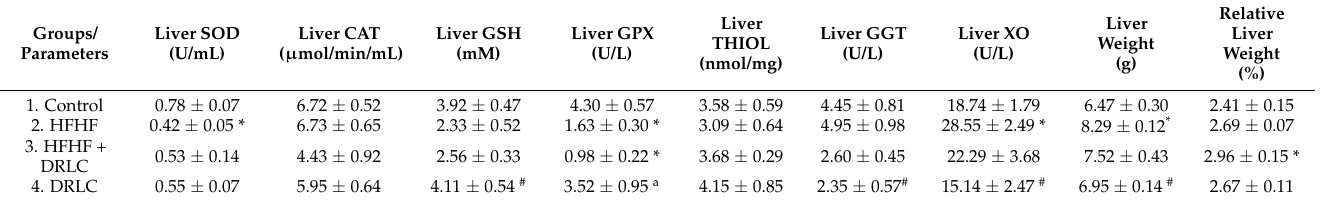
Table 3. Effects of D-ribose-L-cysteine (DRLC) on hepatic tissue oxidative indices, absolute and relative liver weight in male Wistar rats fed with high fructose-high fat (HFHF) diet. Groups/